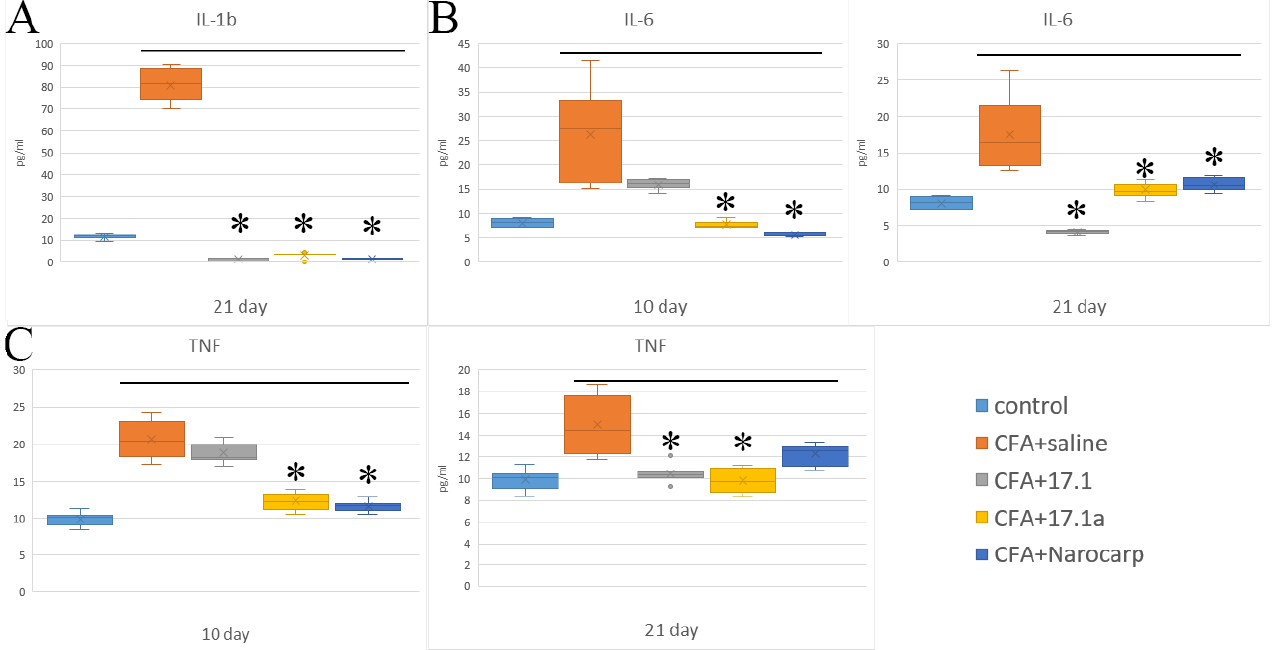
Figure 1. Changes in the level of pro-inflammatory cytokines (( A ) IL-1b; ( B ) IL-6; ( C ) TNF) in the plasma 145 of mice after CFA-induced arthritis. (Control — control animals without CFA injection, plasma 145 of mice after CFA-induced arthritis. (Control—control animals without CFA injection, CFA — animals with induced via CFA arthritis, + saline — animals were treated by phosphate buff- CFA—animals with induced via CFA arthritis, + saline—animals were treated by phosphate buffered ered saline [PBS], +17.1a, +17.1, +Norocarp — animals were treated by a specified agent; n = 7 for saline [PBS], +17.1a, +17.1, +Norocarp—animals were treated by a specified agent; n = 7 for each each group). ( p -value: * < 0.05). group). ( p -value: * <